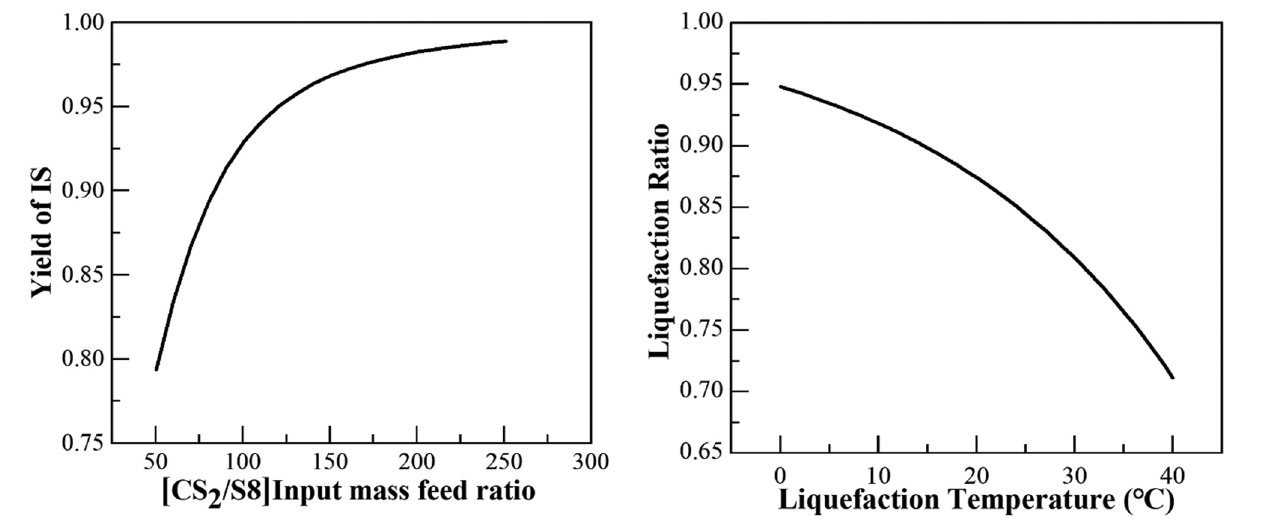
Figure 5: Relationship between the temperature and the liquefaction rate of CS 2 .